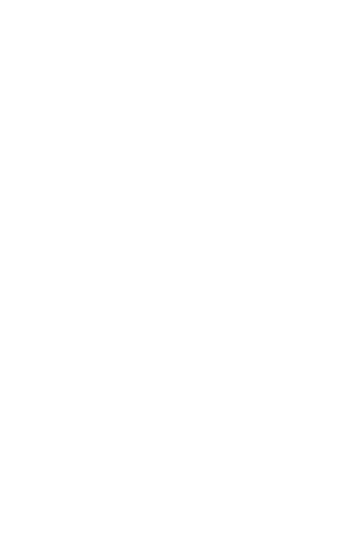
Table 6. Simulated MSE when p = 7 and intercept = 1.